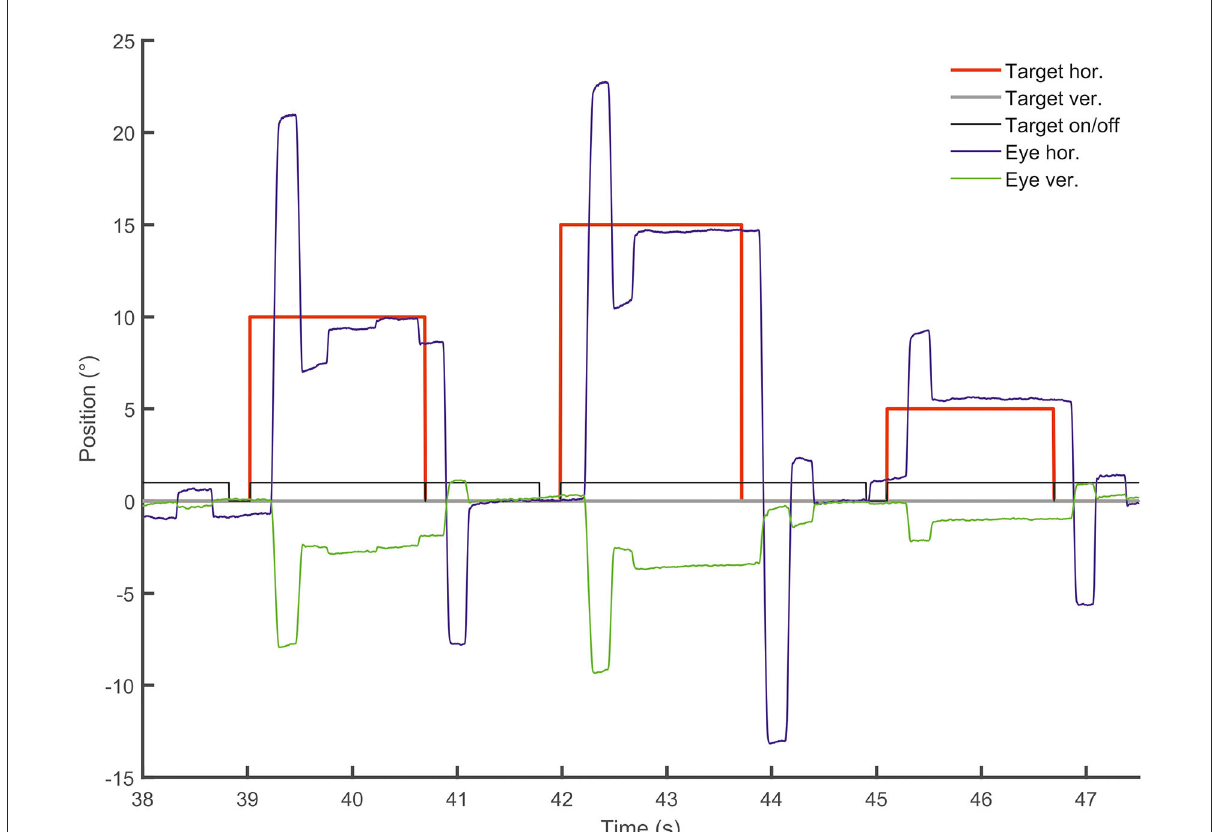
FIGURE5 Vertical deflection during horizontal visually-guided pro-saccades. Vertical (green) and horizontal (blue) eye position is shown over time (sec) following horizontal target displacements (red). Note the large vertical deflection during hypermetric horizontal